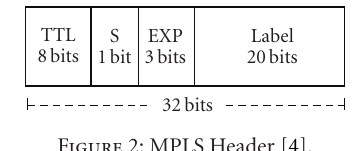
Figure 2: MPLS Header [4].